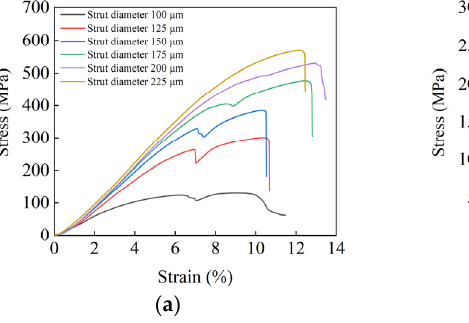
Figure 8. Stress–strain curve of the compression test: ( a ) cell size 1 mm; ( b ) cell size 1.5 mm; ( c ) cell size 2 mm.